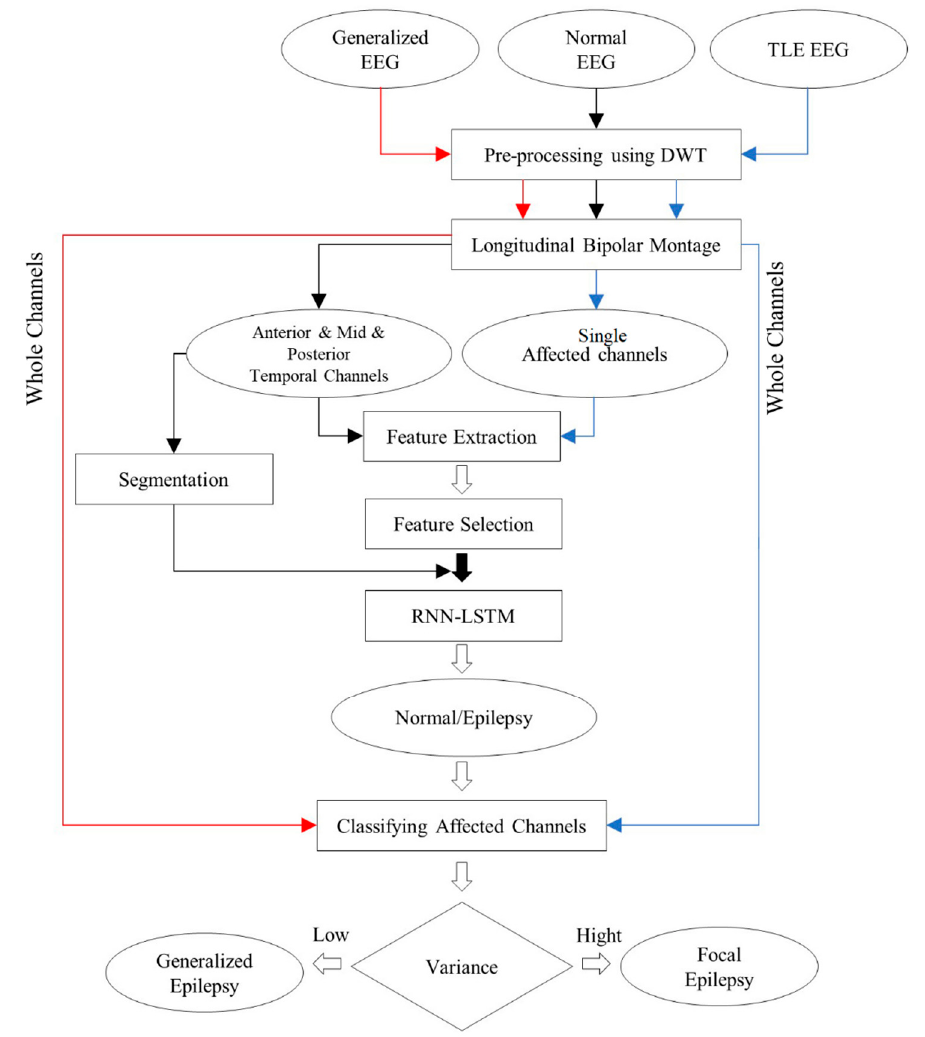
Figure 1. A flowchart of the study.